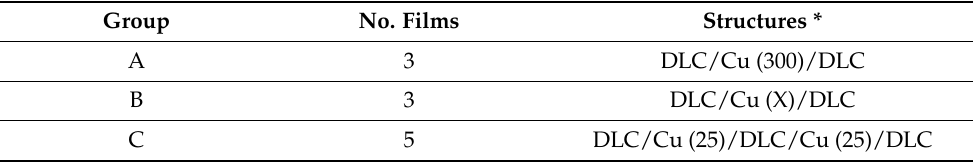
Table 2. Structures of various samples.